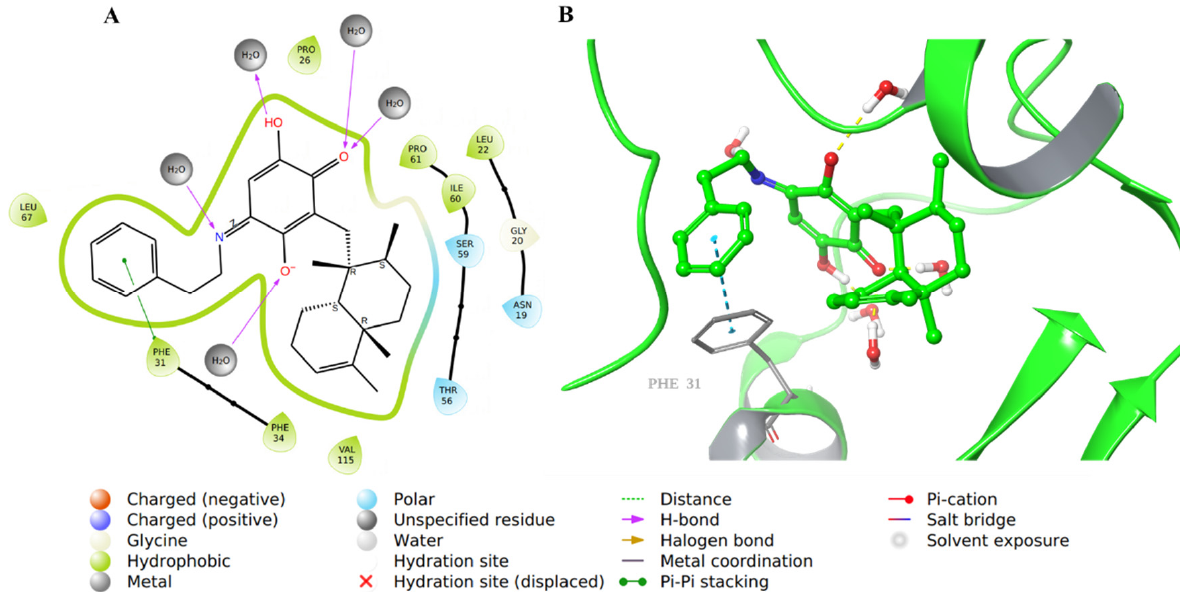
Figure 10. Molecular docking of co-crystallized inhibitor compound 44 in hDHFR (PDB: 1KMV). ( A ) 2D representation of binding interactions of 44 with amino acid residues in the active site within a 3 Å distance; ( B ) 3D representation of 44 in green within the hDHFR active site. The H-bonds and π - π stacking between aromatic rings are in yellow and light blue dotted lines, respectively.